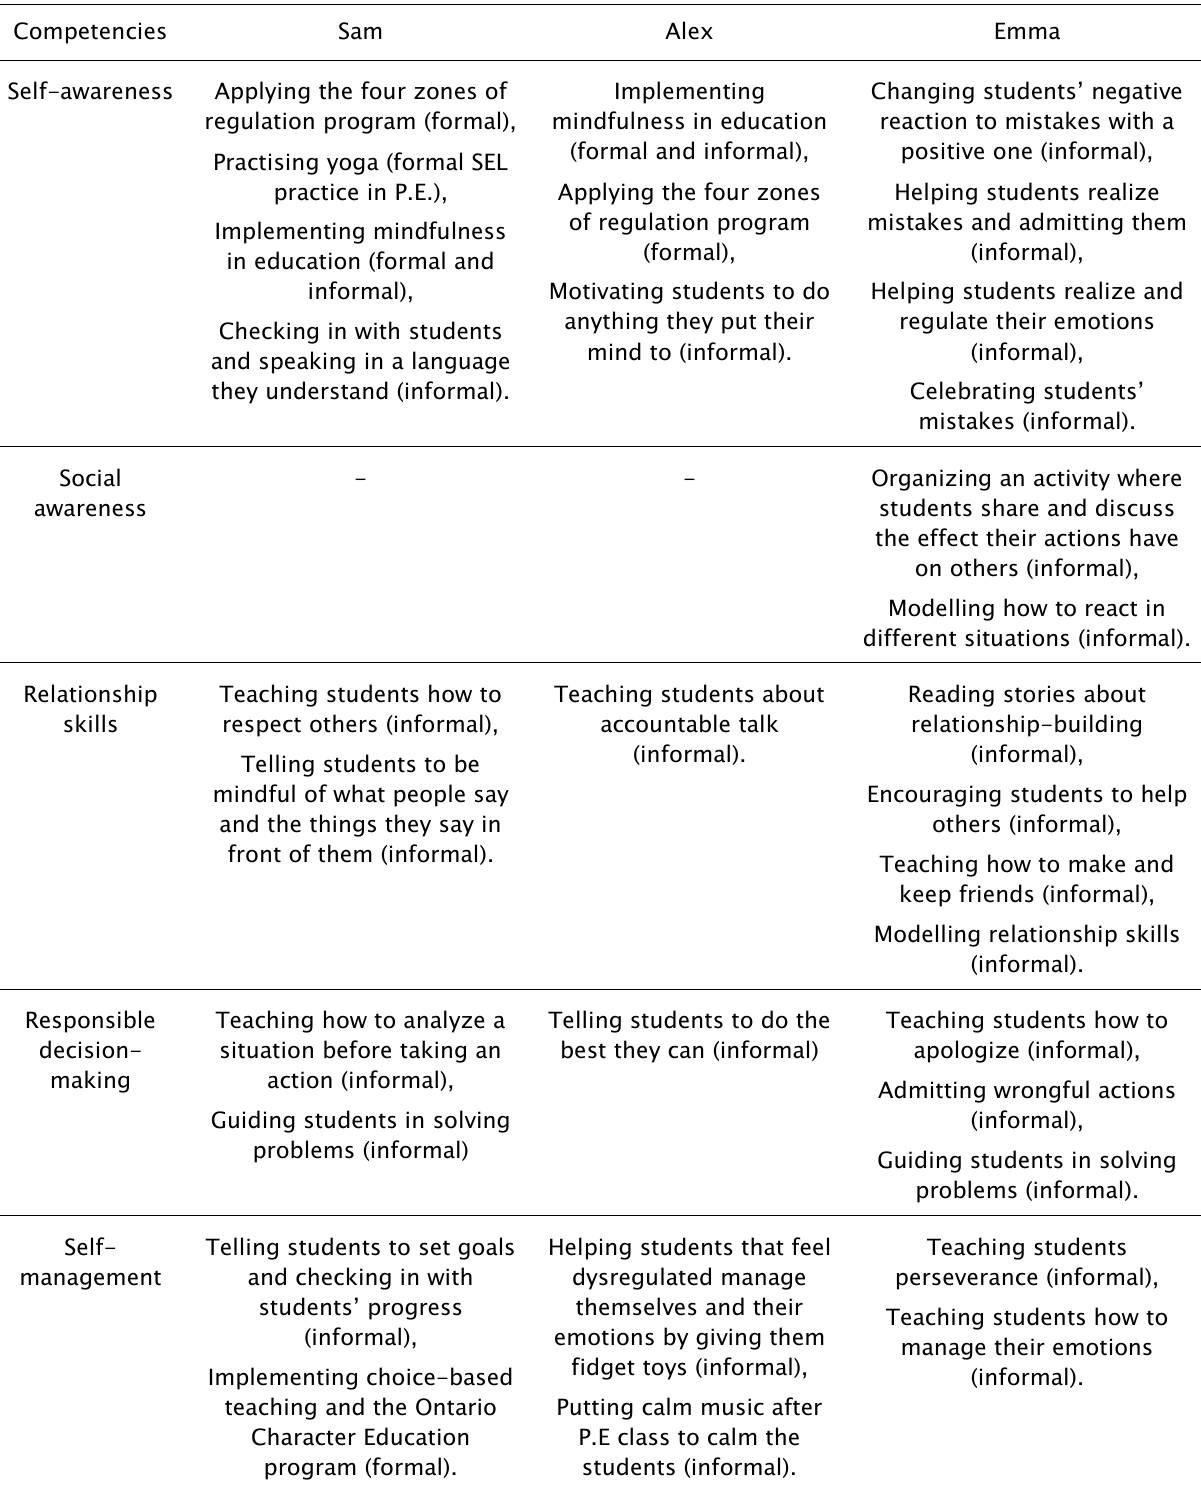
Table 2 Strategies to Teach SEL Competencies Pre-COVID-19